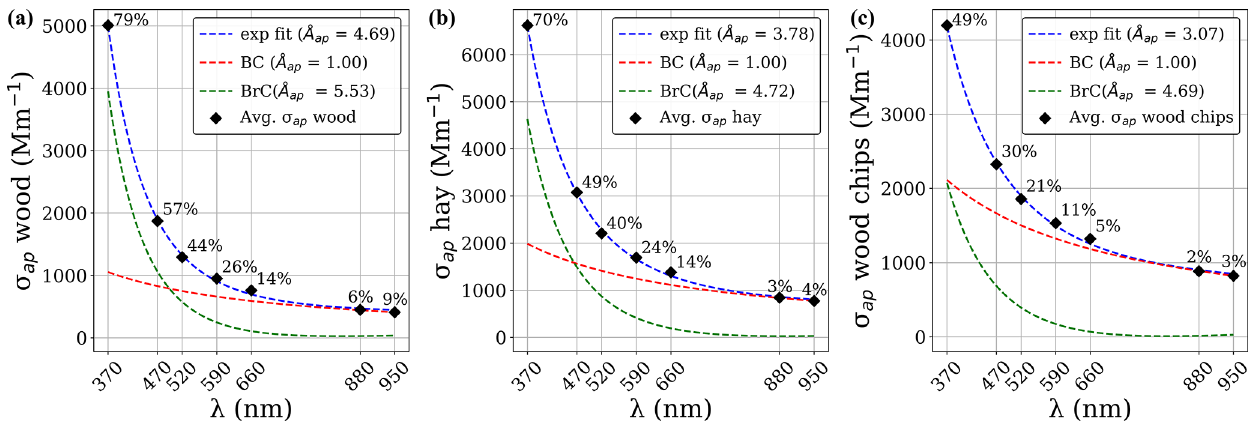
Figure 6. Ångström coefficients based on the exponential fit through the absorption coefficients for wood (a) , hay (b) , and wood chips (c) . The labels represent the relative contribution of BrC absorbers to the total absorption at that wavelength. Table 3. Emission factors (gkg − 1 ) measured using the UAS method as well as those listed by Andreae (2019).